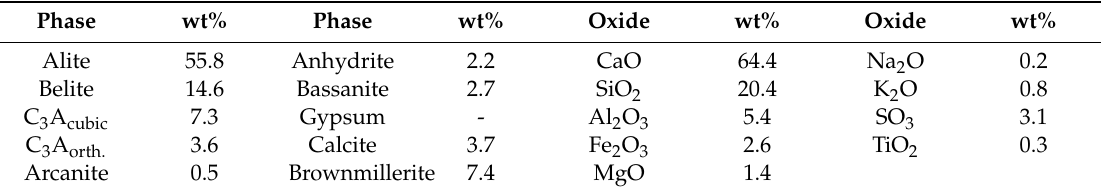
Table 1. Chemical (XRF) and mineralogical composition (XRD) of the CEM I 42.5 R.